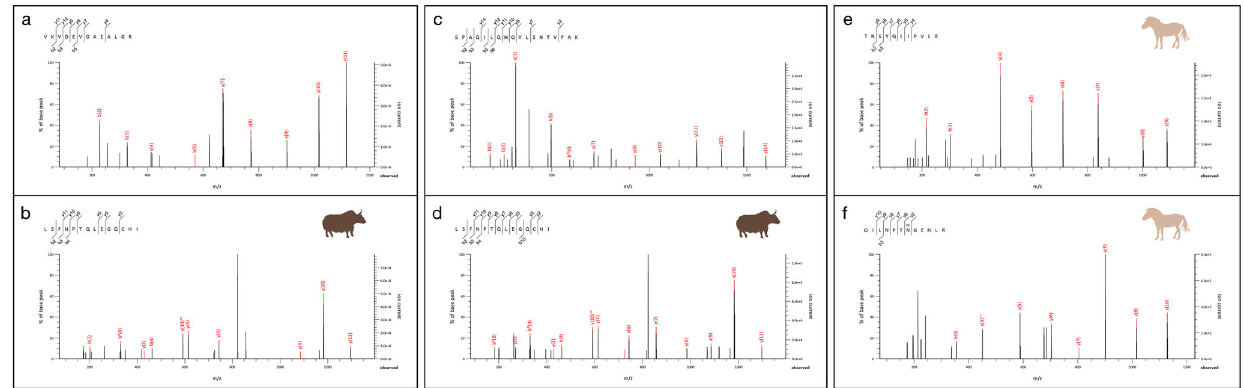
Fig. 5 Spectra for a range of peptides identi fi ed in dental calculus at Khorig. a Hemoglobin subunit beta speci fi c to Pecora (HOR-01). b BLG-E speci fi c to Bos grunniens / mutus (HOR-01). c Kappa casein speci fi c to Bovinae (HOR-27). d BLG-E speci fi c to Bos grunniens / mutus (HOR-27). e Alpha-S2 casein speci fi c to Equus (HOR-08). f Beta-casein speci fi c to